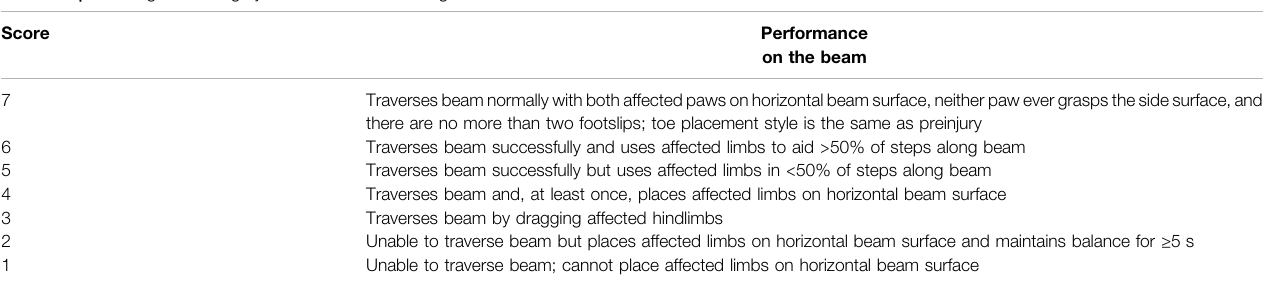
TABLE 4 | Neurological scoring system from beam walking a .